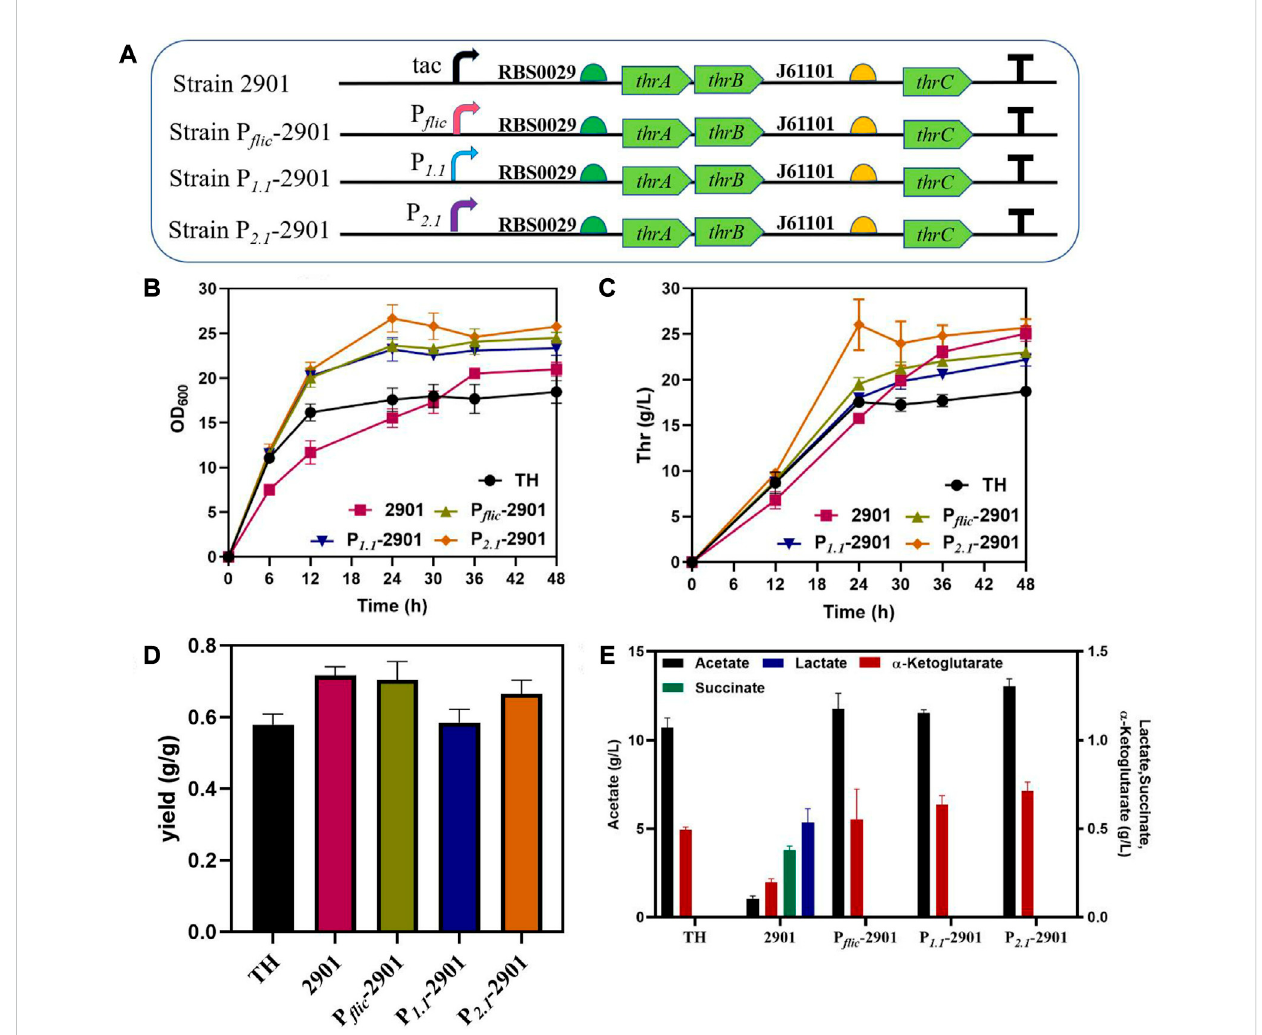
FIGURE 5 Theeffect ofdynamiccontrol ofthe thrABC operonwith astationary phasepromoteron thegrowth andL-threonineproduction in Escherichia coli TH. All results were calculated from three ( n = 3) independent repeats. (A) The strain was constructed by replacing the tac promoter with different promoters. (B) The OD 600 of fermenting strains is controlled by a stationary phase promoter. (C) Samples were taken at 12, 24, 30, 36 and 48 h during fermentation to measure L-threonine production. (D) The yield of the fi nal product was calculated by the ratio of glucose consumption to L-threonine titer. (E) The content of the by-product acetate and other metabolites at the end of fermentation for 48